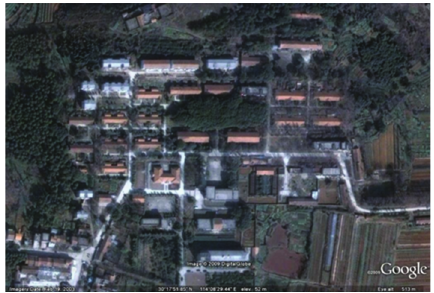
Figure 1: Satellite image of Fruit and Tea Institute, Wuhan, Hubei, China. Top of the image is the north (Google Earth, version 6.0.3.2197,